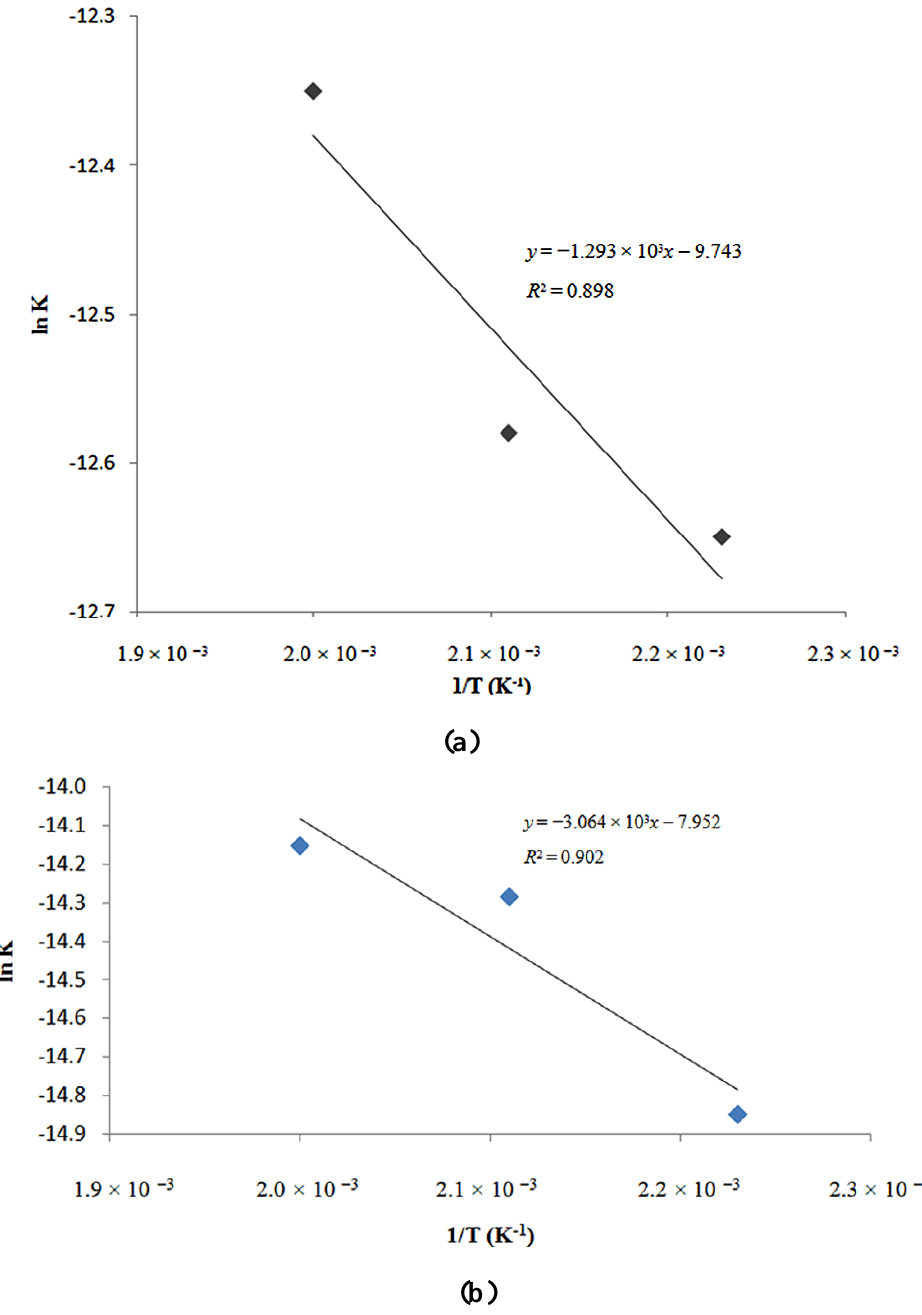
Figure 11. Graphs of lnK vs . 1/T are plotted for Au and Cu, respectively, to obtain the activation energy Δ Q